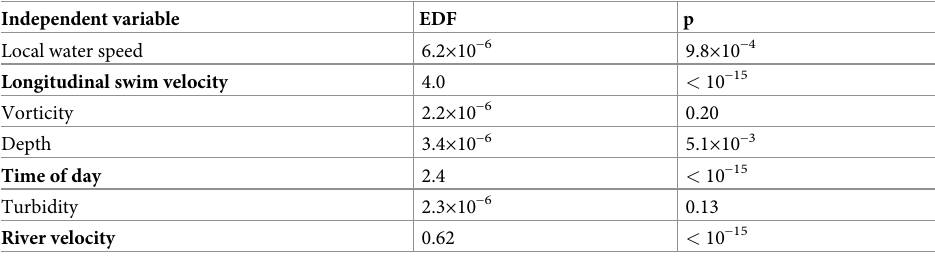
Table 4. Summary of GAM for lateral swimming